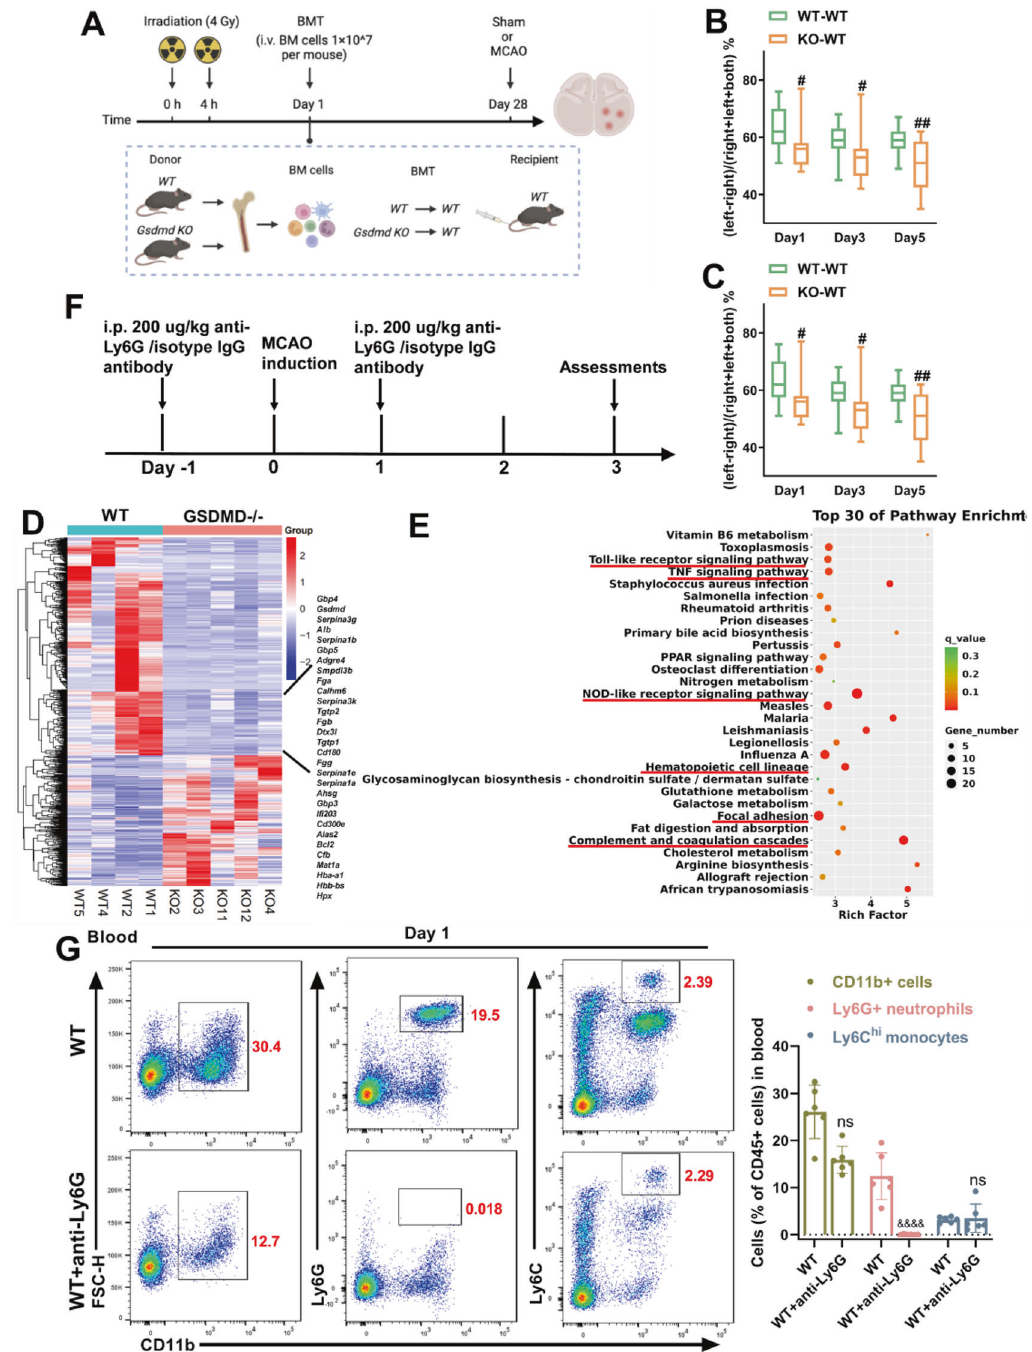
Fig. 5 Neutrophil-speci fi c GSDMD contributes to high level of neutrophils after MCAO. A Experimental overview: Bone marrow from C57BL/6J WT and GSDMD − / − mice was transplanted into WT recipients, and MCAO was induced after 4 weeks. B , C Neurological tests were performed to evaluate the motor, sensory, and balance functions of bone marrow chimeric mice on days 1, 3, and 5 after MCAO ( n = 13 – 15). D Heatmap showing genes identi fi ed by RNA-Seq analysis of CD11b + cells isolated from the blood of WT and GSDMD − / − mice on day 1 after MCAO ( n = 4 – 5). E GO analysis shows the most signi fi cantly enriched signaling pathways in CD11b + cells sorted from the blood of WT and GSDMD − / − mice on day 1 after MCAO ( n = 4 – 5). F Flowchart illustrating anti-Ly6G administration and the experimental design. The mice received intraperitoneal (i.p.) injections of anti-Ly6G (200 µg) or an equal volume of isotype IgG 24 h before and after MCAO. G Flow cytometric gating of neutrophils and monocytes to validate the successful elimination of neutrophils ( n = 6). H , I Flow cytometric analysis of neutrophils and monocytes in the blood ( n = 7) and bone marrow ( n = 6 – 7) between the anti-Ly6G group and the isotype IgG group 3 days after MCAO. J Flow cytometric analysis of HSC, CMP and GMP in the bone marrow between the anti-Ly6G group and the isotype IgG group 3 days after MCAO ( n = 6 – 7). The data are presented as the mean ± SD. Statistical analysis: multiple two-tailed unpaired Student ’ s t test ( B , C , F – J ). ns not signi fi cant, # P < 0.05, ## P < 0.01, ### P < 0.001 vs MCAO of WT bone marrow transplantation into WT mice. & P < 0.05, && P < 0.01, &&& P < 0.001, &&&& P < 0.0001 vs WT mice after